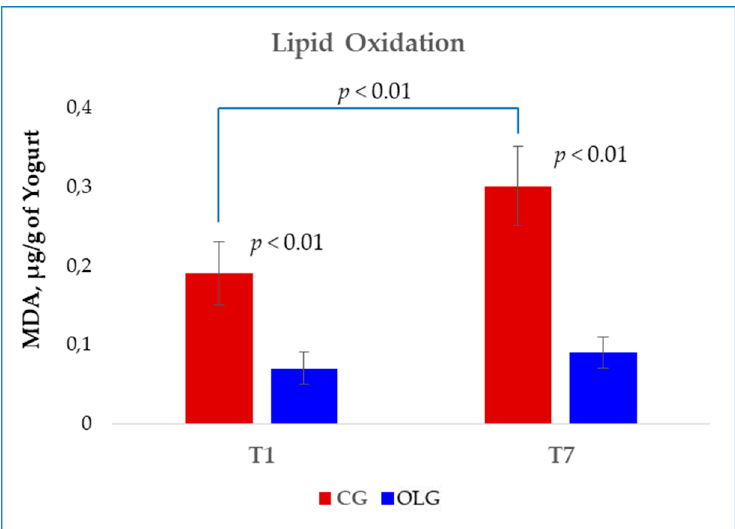
Figure 1. Lipid oxidation evaluated in yogurt samples obtained from goats fed the standard diet (CG) and goats that received the dietary supplementation with olive leaves (OLG). Samples were analyzed after 1 day (T1) and 7 days of storage (T7) at 4 °C. Malondialdehyde (MDA).